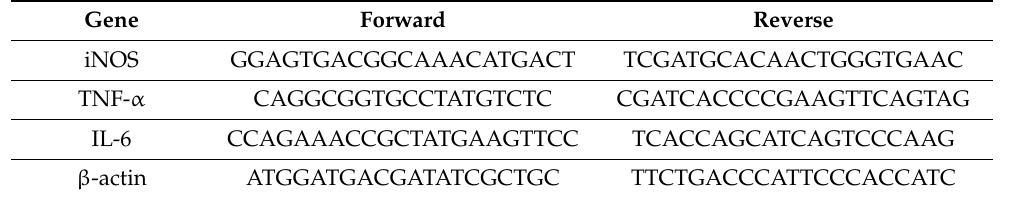
Table 1. Primers used for expression